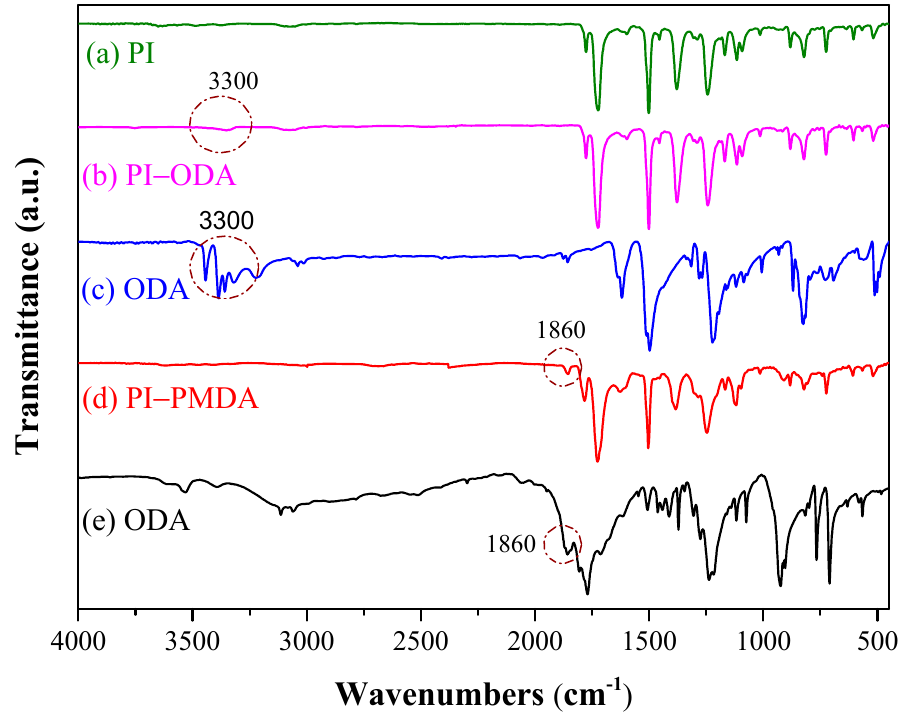
Figure 2. FTIR of ( a ) PI, ( b ) PIODA, ( c ) ODA, ( d ) PIPMDA, and ( e ) PMDA. Comparing the PI-ODA spectra with that of PI (Figure 2a,b), the characteristic C=O absorption (1720 and 1777 cm − 1 ) and the C-N absorption at 1390 cm − 1 are almost identical. In the spectra of PI-ODA, the N-H absorption peak is weak but observable. This indicates